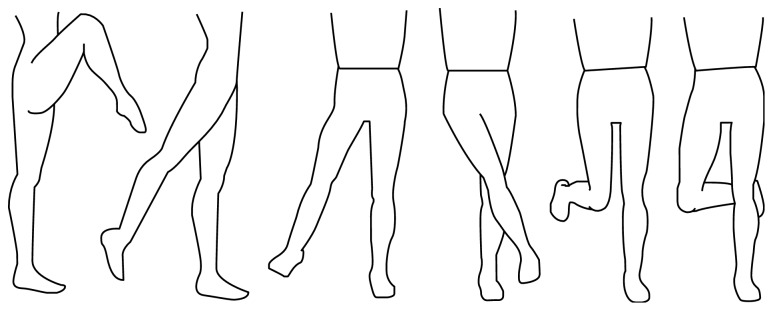
Poses to determine maximum movement amplitudes of the hip DOFs: maximum flexion, extension, abduction, adduction, and internal and external rotation.